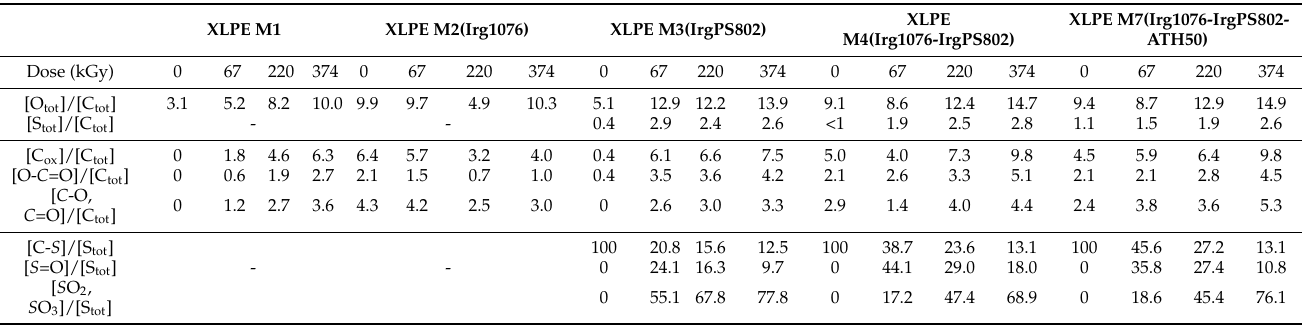
Table 3. Relative atomic ratio (at.%) obtained from curve-fitted XPS core-level spectra ( C -1s, O -1s and S -2p) for the five XLPE materials, non-irradiated and irradiated at 67 kGy, at 220 kGy and at 374 kGy. Irradiations realised at medium dose rate (78 Gy h − 1 ) with γ -rays under oxidative atmosphere. C ox refers to all oxidised carbon bonds, O- C =O, C -O and C =O. XLPE